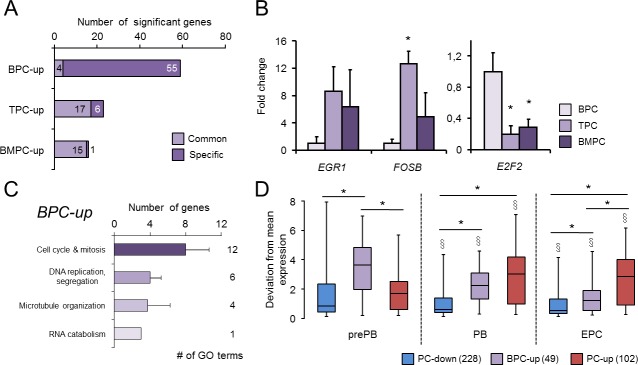
Transcriptional markers of PC subtypes.(A) The number of significantly up-regulated genes in one PC-subtype (Specific), or in more than one PC-subtype (Common) are indicated. (B) RT-qPCR assays in independent samples (n = 3 for BPC, TPC and n = 4 for BMPC) for selected genes. *, P ≤ 0.05, Mann-Whitney test related to BPC. (C) GO enrichment analysis for up-regulated genes in BPC (BPC-up) (P< 0.05, DAVID) as represented in Fig 2. (D) Box-and-whisker plots of the PC-down, BPC-up and PC-up genes that overlapped with the successive stages obtained in an in vitro BC differentiation system defined in GenomicScape; this included pre-plasmablasts (prePB), plasmablasts (PB) and early plasma cells (EPC) stages [20]. *, P < 0.05 in Student’s t-tests between signatures within the same GenomicScape cell subtype; §, P< 0.05 Student’s t-tests between each cell subtype and prePB within the same signature.